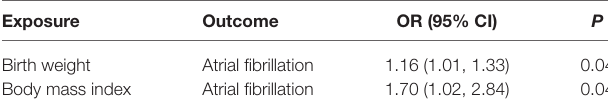
TABLE 2 | Multivariable Mendelian randomization analysis for association between birth weight and atrial fibrillation conditional on body mass index. Exposure Outcome